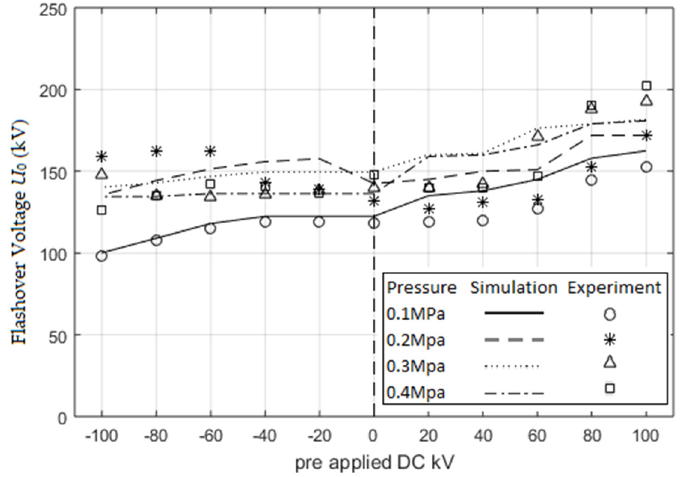
Figure 7. Breakdown characteristics of superimposed flashover voltages without spacer (Case 1), particle size l = 10 mm, D = 50 mm.